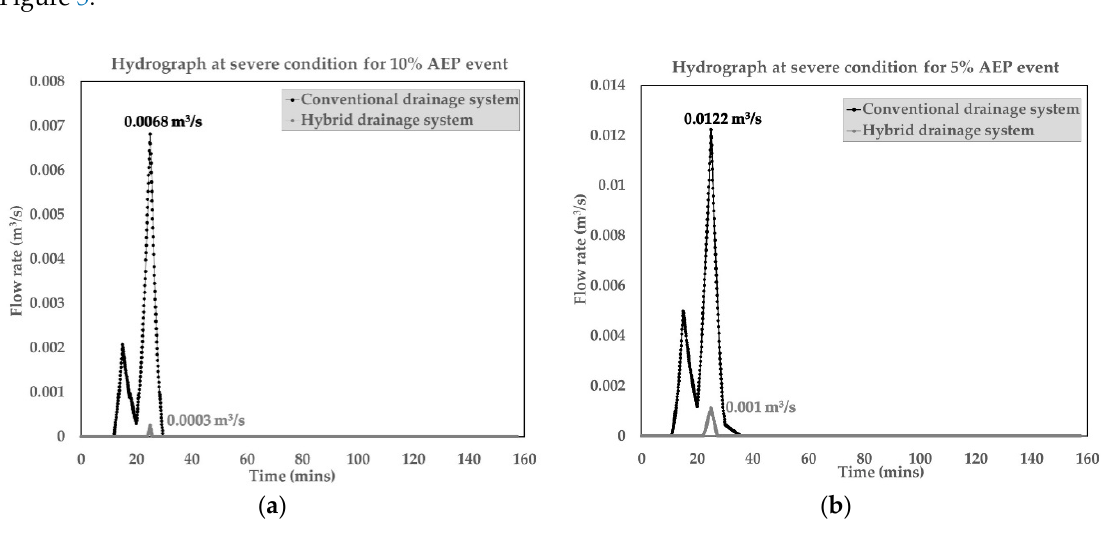
Table 5. Cost of detention basin for both drainage systems.